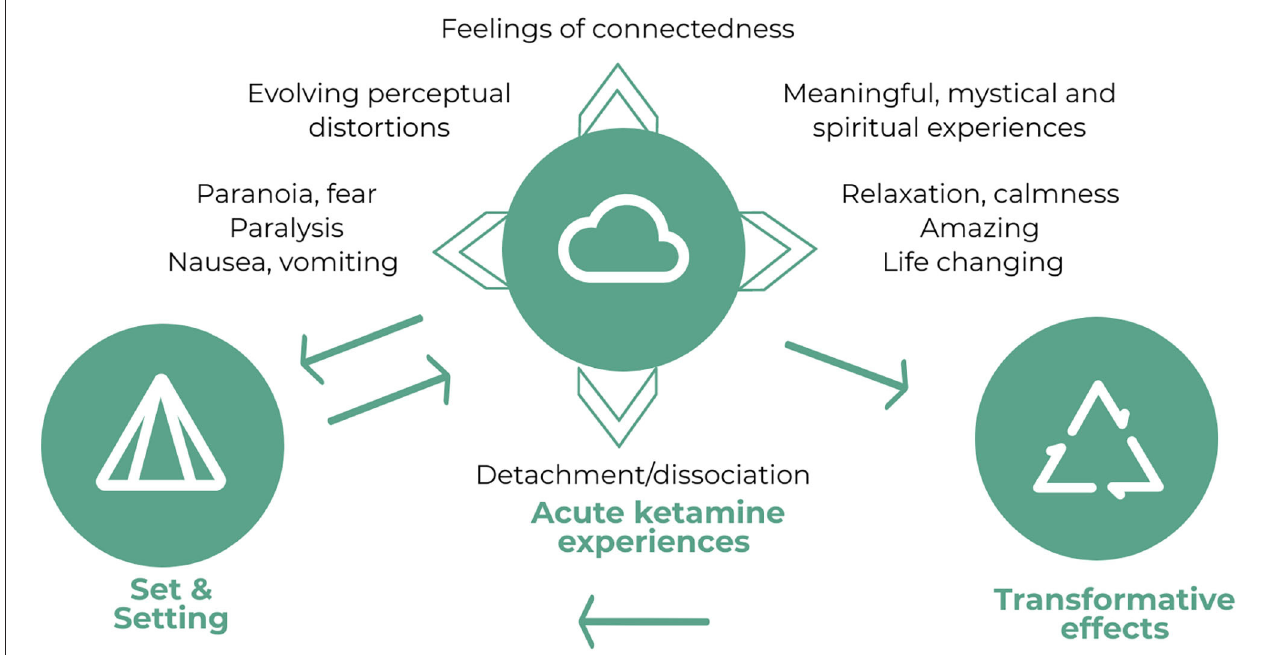
FIGURE 1 | Diagram depicting the relationship between set and setting, the acute ketamine experiences (inherent contradictions of the experience, rapidly fluctuating and changing experiences, and meaningful, spiritual and mystical experiences) and transformative effects of the infusions and the trial. Whilst set and setting are influential in determining the acute ketamine experiences, experiences from the first two infusions and the transformative effects also contribute to the set of the subsequent infusions as expectations. As discussed in theme 4, the acute ketamine experiences, particularly feelings of connectedness and dissociation also appeared to be related to the transformative